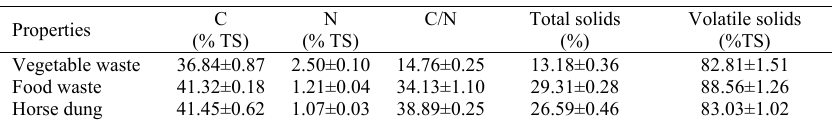
Table 1: Properties of the raw materials (number of samples n = 3)